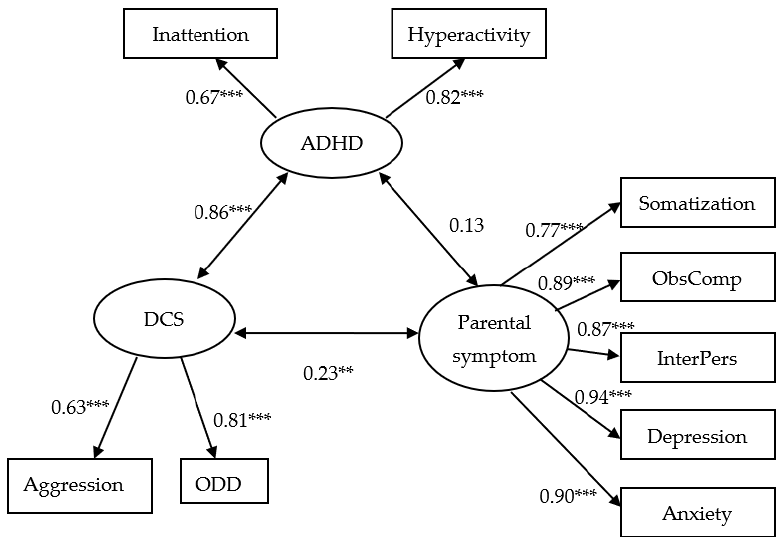
Figure 1. Three factor’s confirmatory factor analysis (CFA) model (positing the existence of bivariate